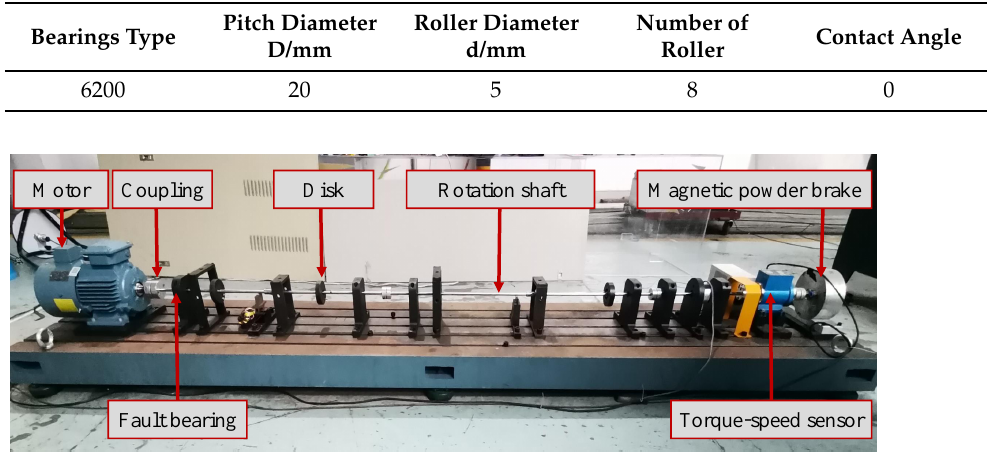
Figure 11. Tail rotor drive train test